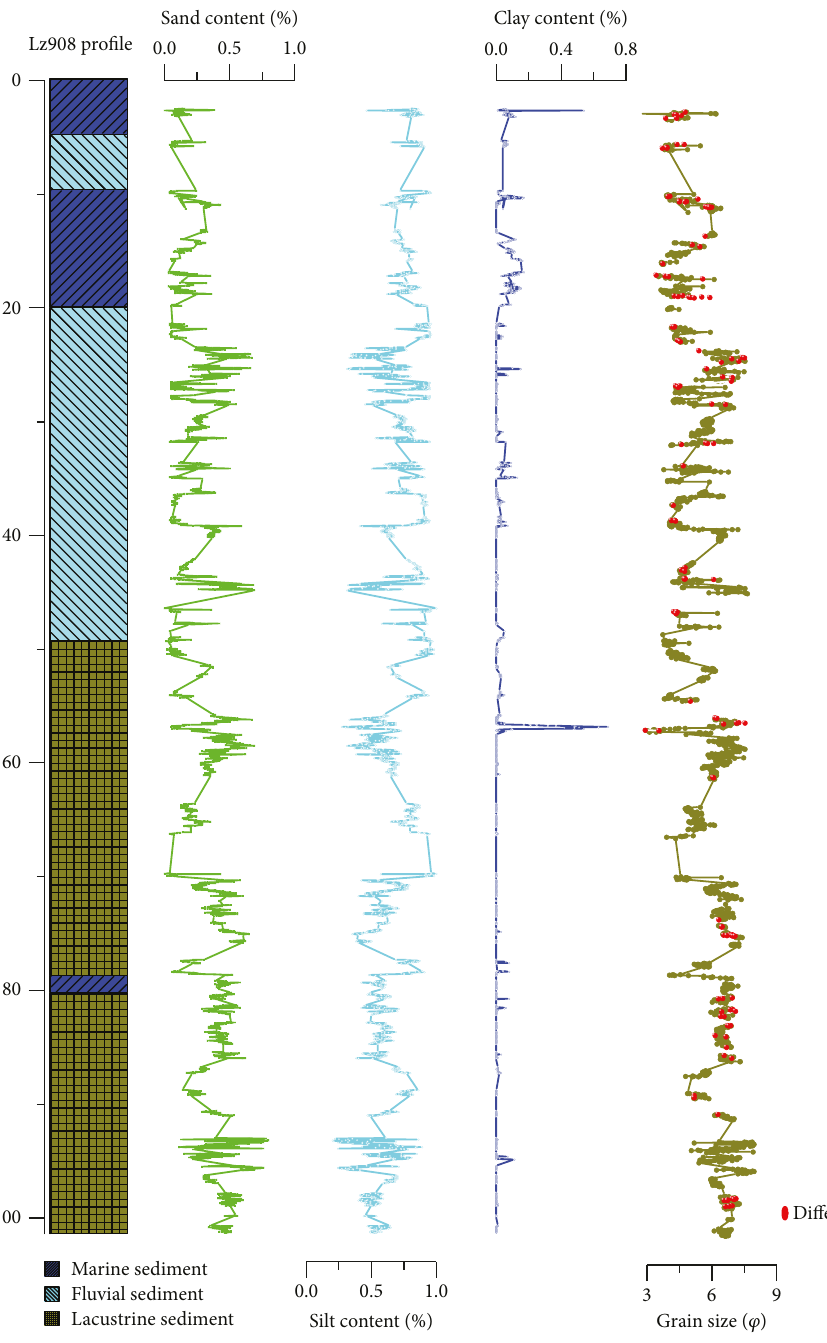
Figure 10: Result comparison (pro fi le of the Lz908 was reported in Yi et